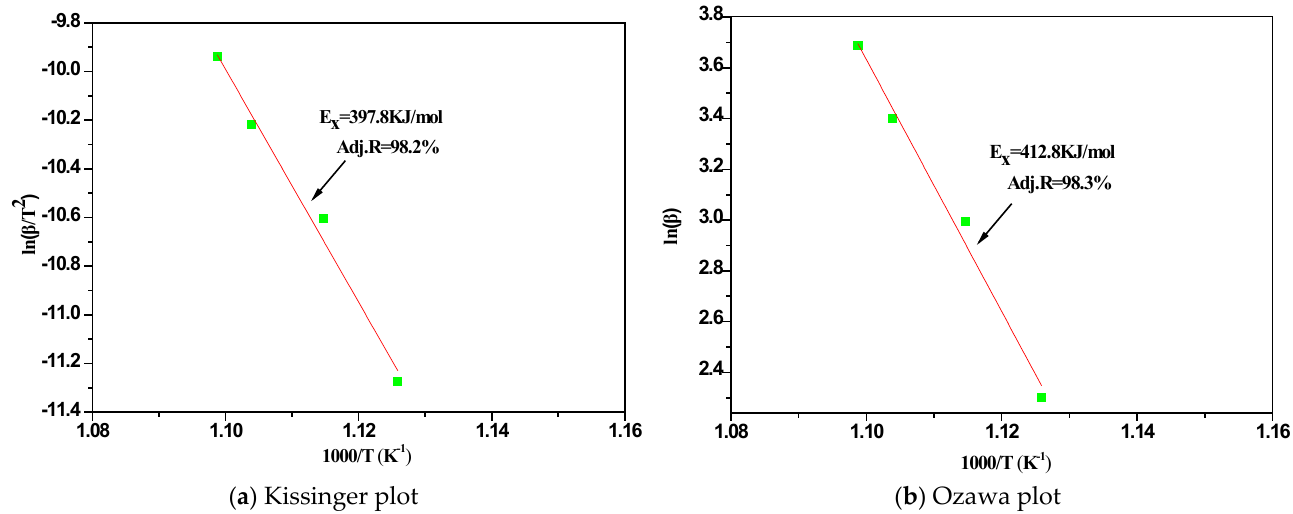
Figure 5. The Kissinger and Ozawa plots of the Al-Ni amorphous alloy.